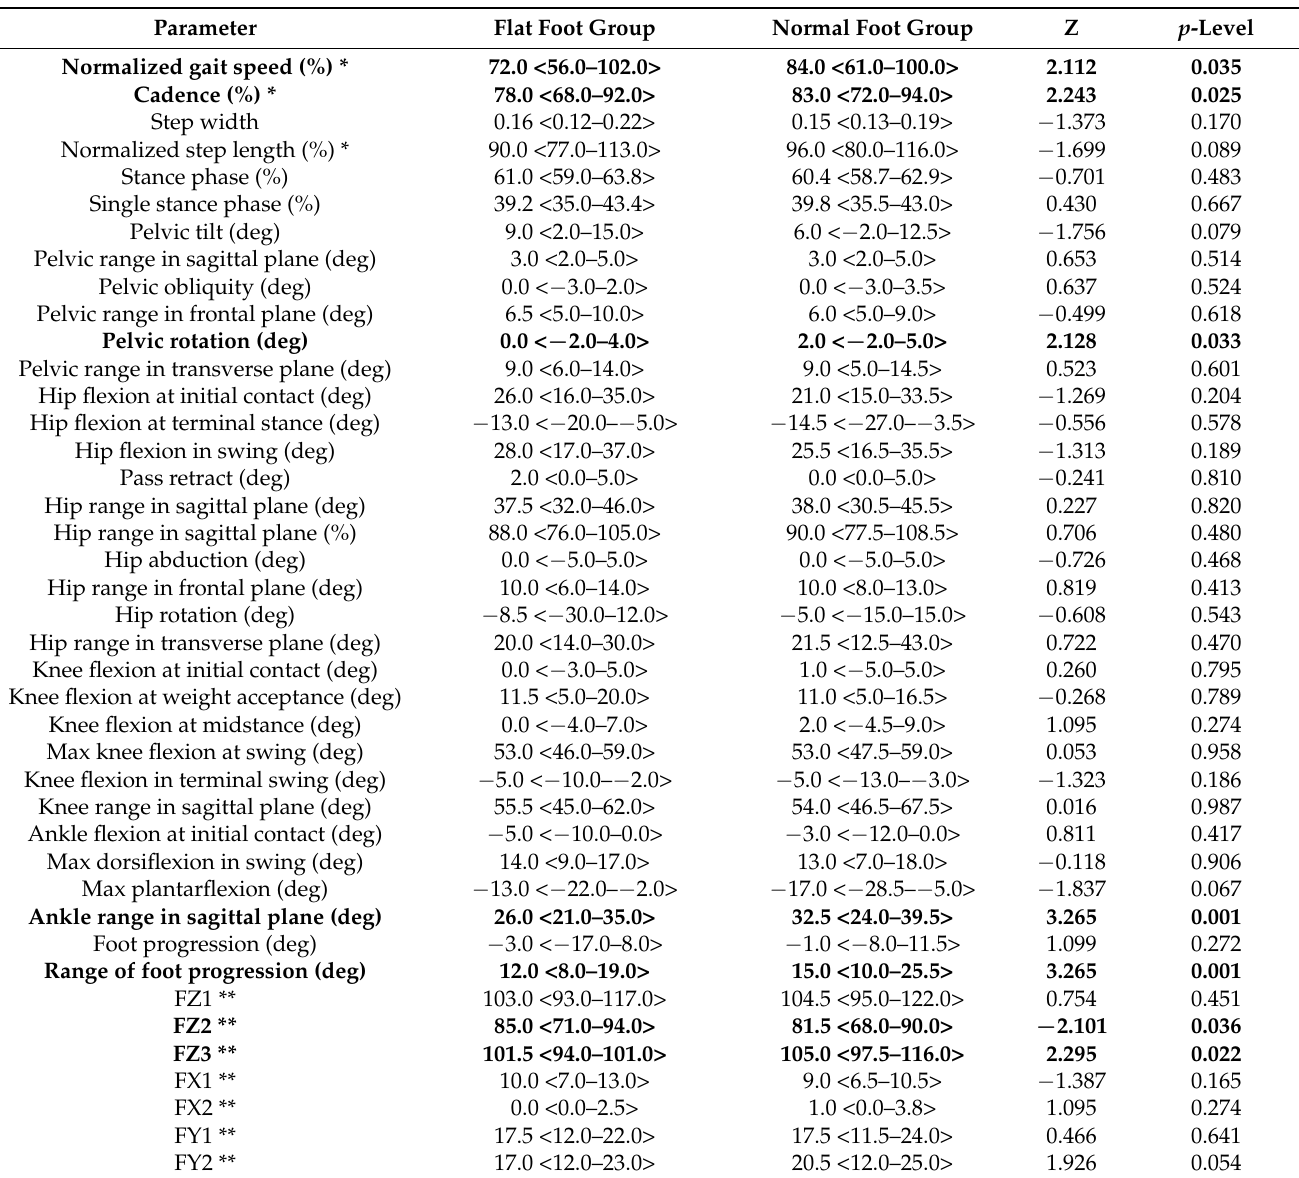
Table 3. The gait parameters when the feet were divided according to the Arch Index from pedobaro- grahy. The parameters were summarized by medians and 10th and 90th percentiles. The statistically significant differences were marked by bolded font. Z—the results of the Mann-Whitney U test, p -level—probability value